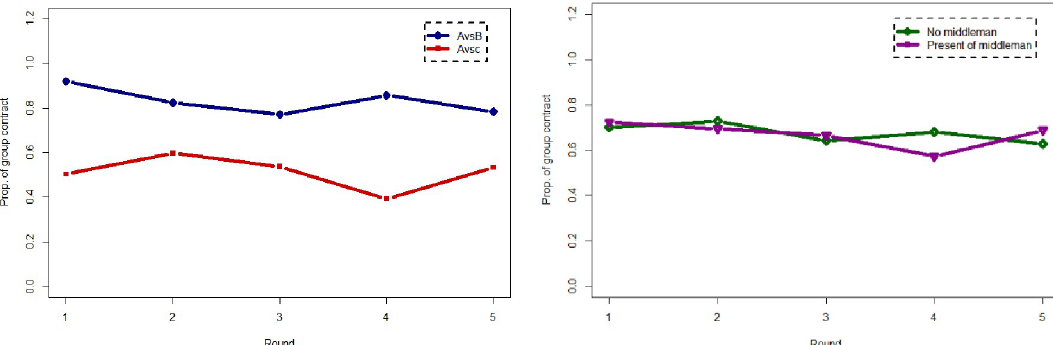
Fig 1. Choice of group contract under different contract offer (left) and in the presence of an organizer